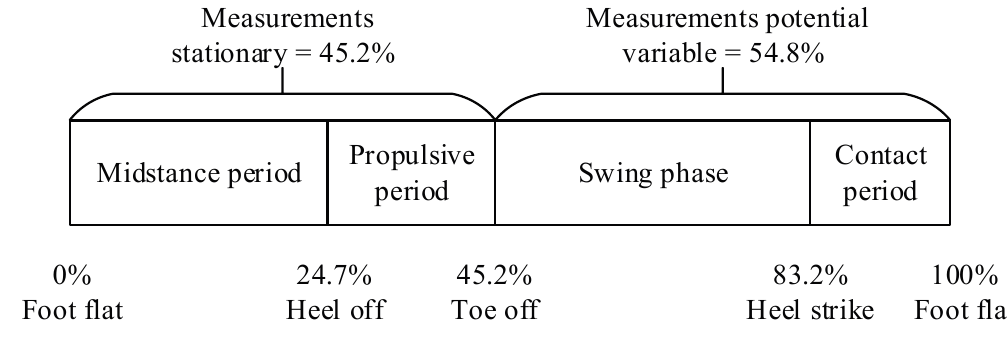
Figure 3. Phases in a typical gait cycle.